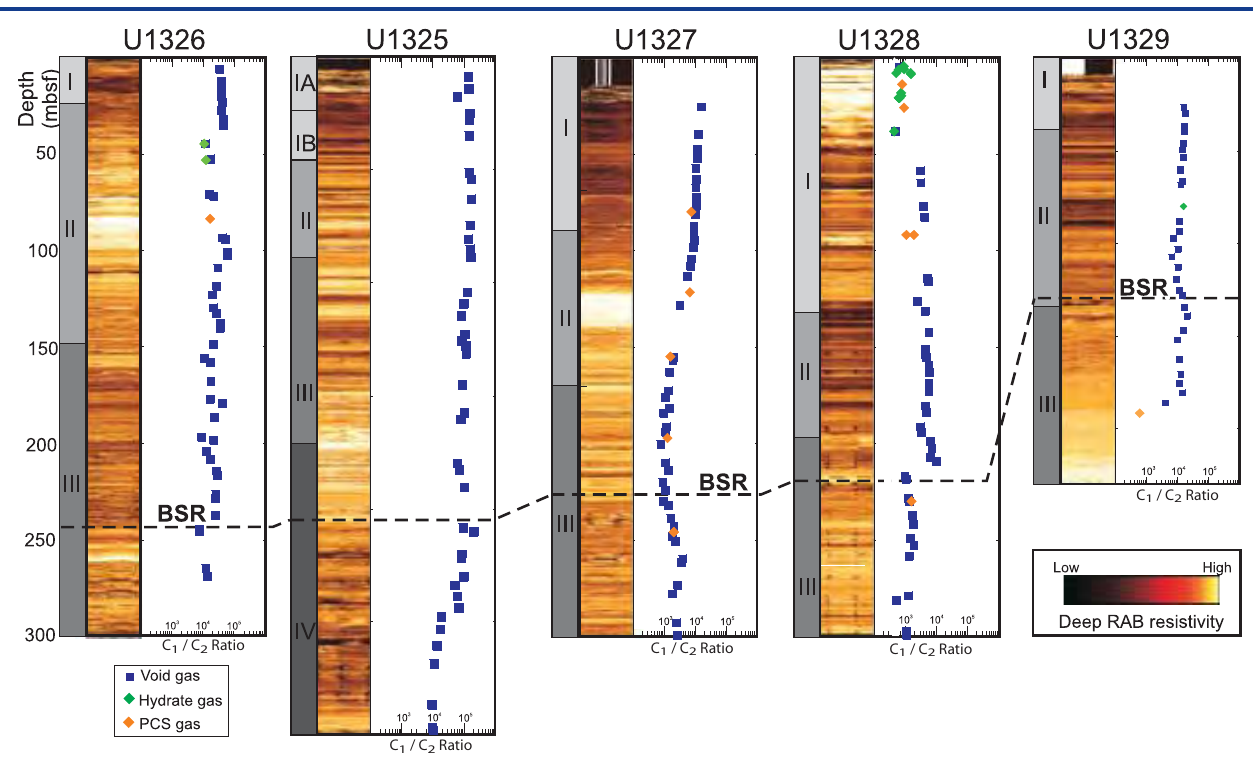
Figure 3. Summary of Expedition 311 C 1 /C 2 gas profi les, including data from void, gas hydrate, and PCS gas. Also shown are lithostratigraphic units and LWD RAB resistivity images and location of